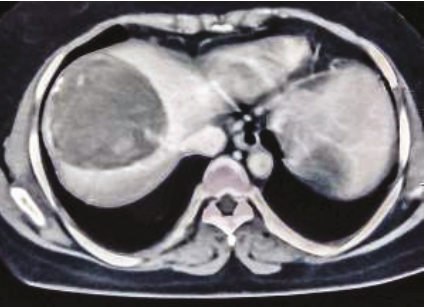
Figure 2: CT scan of the abdomen showing giant multiloculated hydatid cyst with septations in the left iliac fossa.